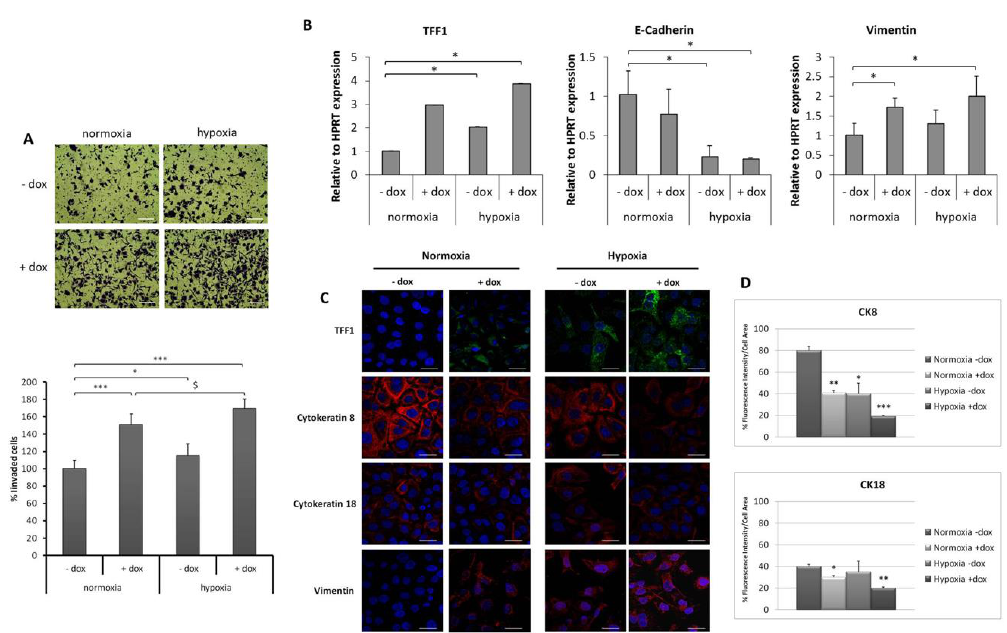
Figure 4. Effect of TFF1-enriched conditioned medium (CM) on the invasive ability of AGS cells and the expression of EMT markers. ( A ) Invasion through Matrigel of AGS cells treated with conditioned medium from AGS-AC1 cells (CM, −dox) or from TFF1 hyper-expressing AGS-AC1 cells (CM,